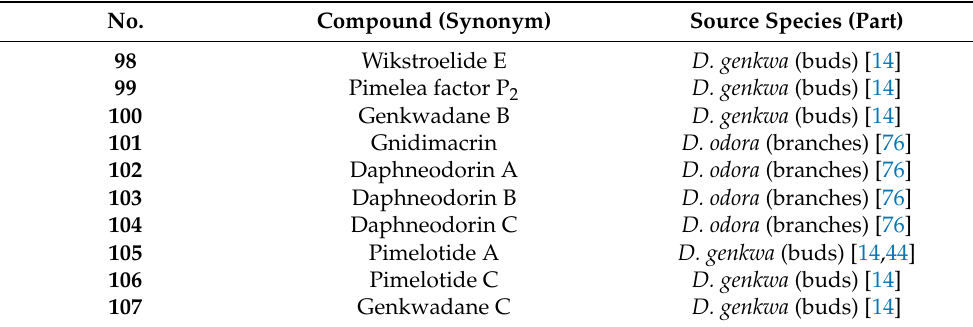
Table 5. Structures and sources of 1-alkyldaphnanes ( 98 – 107 ).